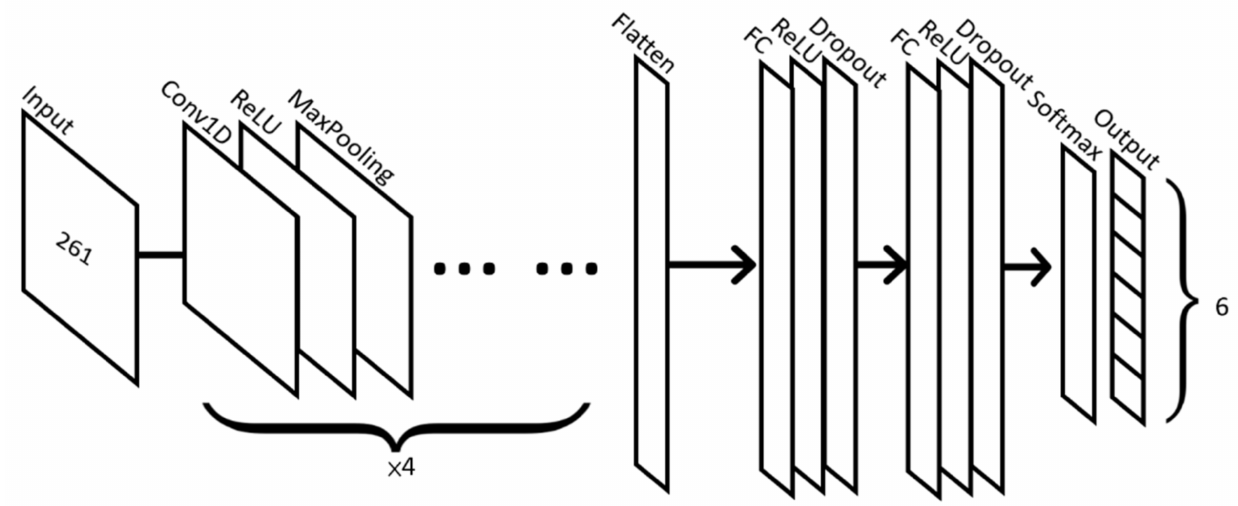
Figure 2. Illustration of the CNN model architecture with convolution part (Conv1D, ReLU and MaxPooling) and MLP part (fully connected, dropout layer and soft-max). The input is the 1D array of the profile data, consisting of 261 points and the output is the array of 6 classes of our